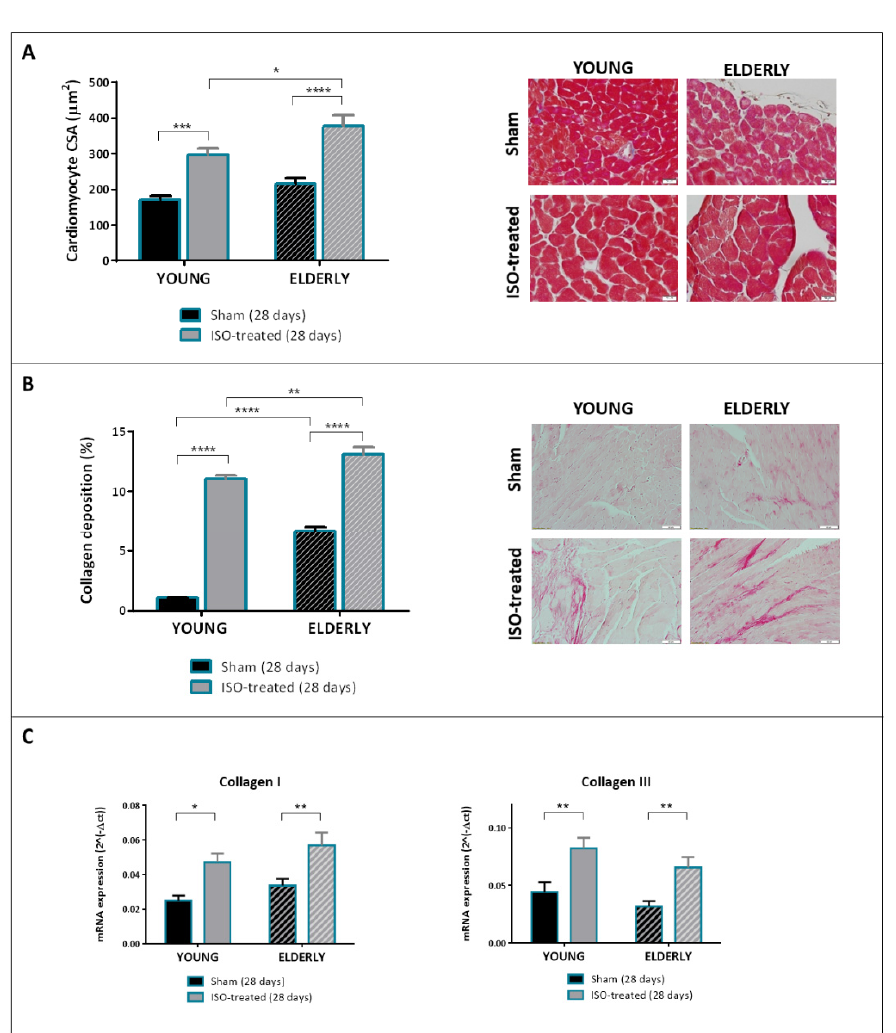
Figure 2. Histological findings and mRNA expression analyses at 28 days after exposure to isoproterenol or saline infusion in young and elderly mice. ( A ) Cardiomyocyte cross-sectional area (CSA) in the four study groups. A representative microphotograph for each one of them is shown (magnification ×40). N = 7/5 in sham/ISO-treated young mice; N = 7/5 in sham/ISO-treated elderly mice. ( B ) Quantification of collagen deposition in picrosirius-stained sections in the four study groups. Representative microphotographs are shown (magnification ×20). N = 5/7 in sham/ISO-treated young mice; N = 7/5 in sham/ISO-treated elderly mice. ( C ) mRNA expression of collagen I and collagen III in the four study groups. N = 8/6 in sham/ISO-treated young mice; N = 8/6 in sham/ISO-treated elderly mice. * p < 0.05, ** p < 0.01, *** p < 0.001, **** p < 0.0001.